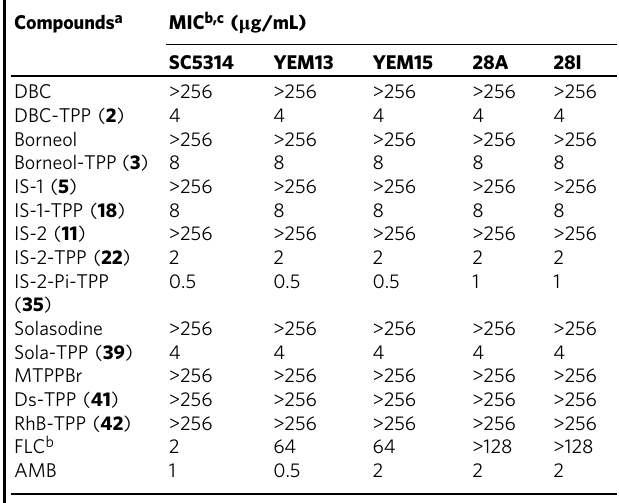
Table 1 Antifungal activities of representative